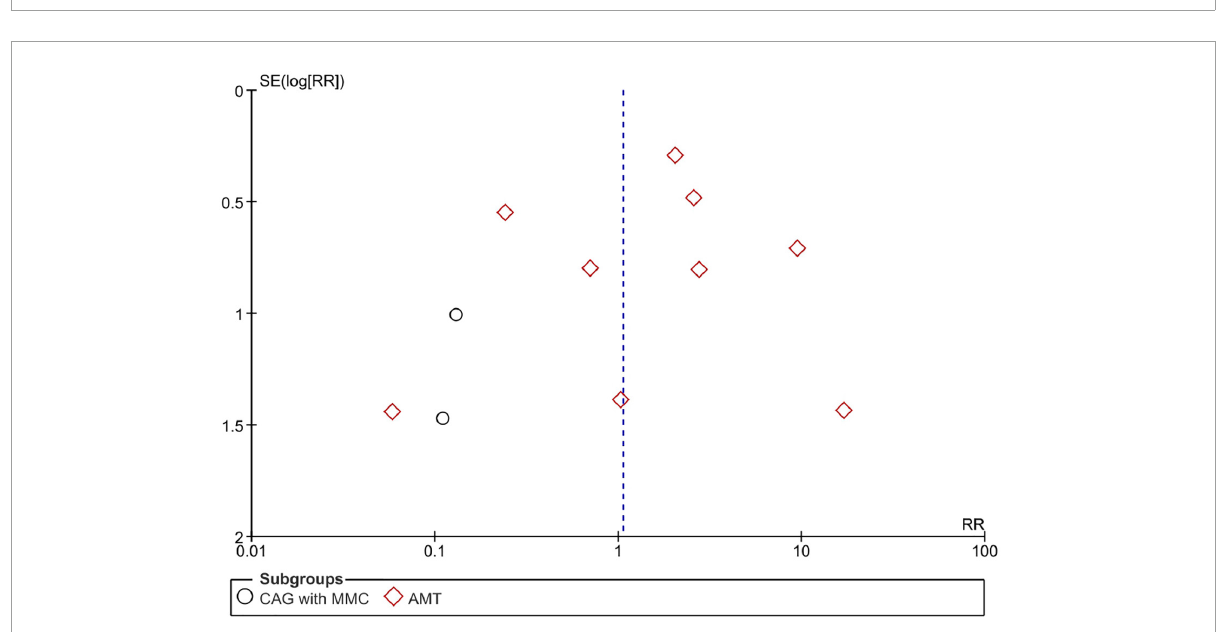
FIGURE6 Funnel plot of rate of recurrence. SE, standard error; RR, risk ratio; CAG, conjunctival autograft; AMT, amniotic membrane transplantation; MMC, mitomycin